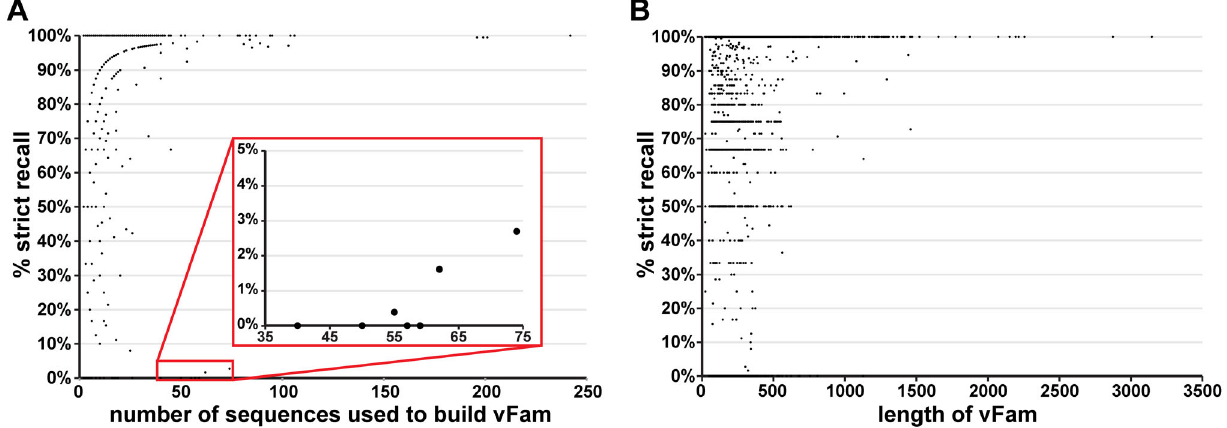
Figure 3. Viral sequence recall as a function of other vFam metrics. For each vFam, the percentage of the vFam’s sequences correctly recalled by the HMM with a score better than all non-viral controls (% strict recall) in the cross-validation experiments is plotted as a function of (A) the number of sequences used to build the vFam; red box (zoomed and inset) highlights HMMs built from 40 or more sequences with strict recall less than 3%, (B) the length of the vFam, (C) the positional relative entropy in the vFam, and (D) the total relative entropy in the